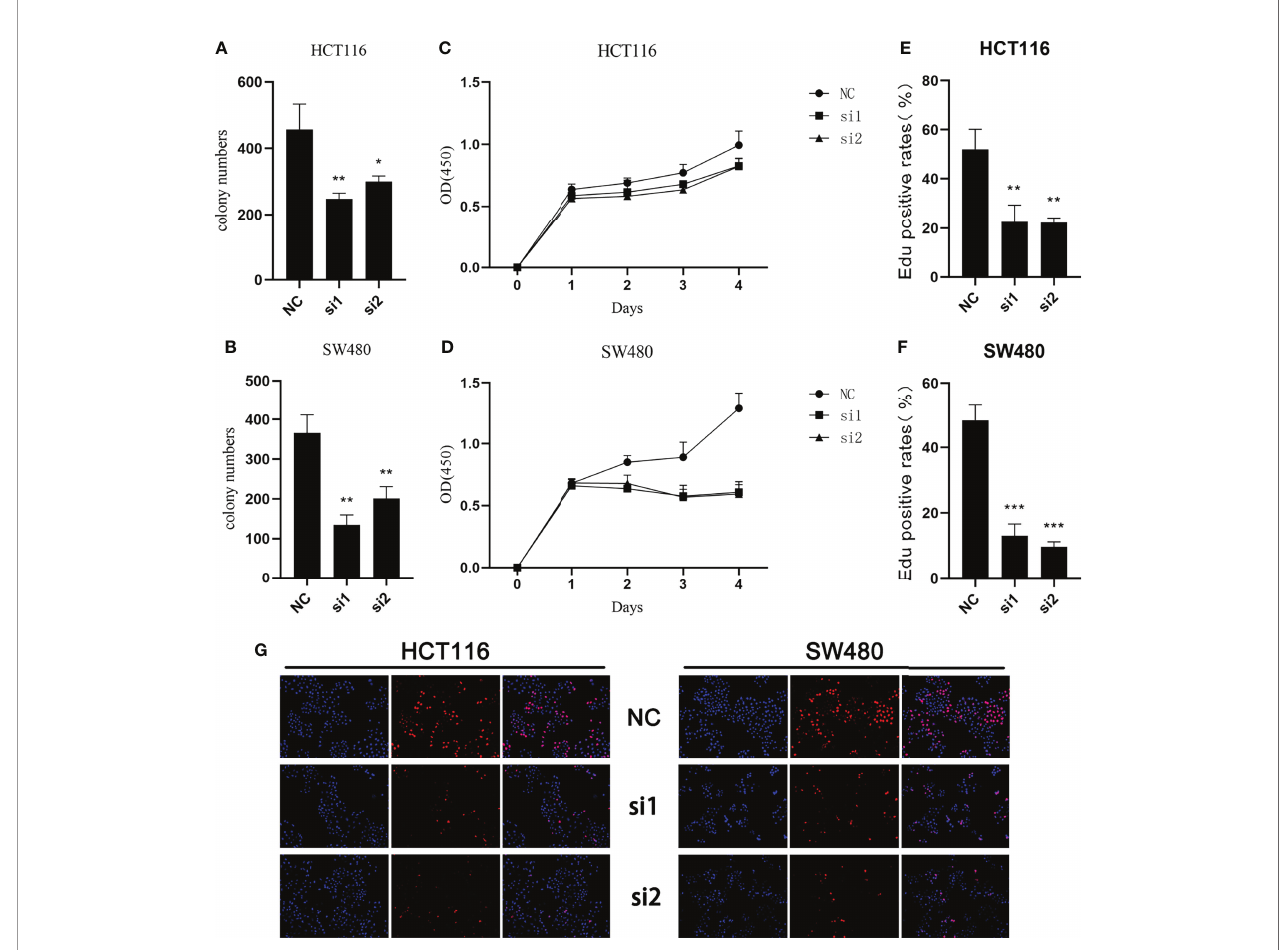
FIGURE 6 | Effects of SCG2 on CRC cells proliferation. (A, B) SCG2 knockdown signi fi cantly reduced colony numbers of HCT116 (A) and SW480 (B) cell lines. (C, D) Reduced proliferative capacity of SCG2 knockdown HCT116 (C) and SW480 (D) cell lines in CCK8 array. (E-G) EdU assay (G , left: DAPI, middle: EdU, right: Merge ) to detect the proliferative ability of CRC cells in the control group and SCG2 downregulation group. SCG2 knockdown signi fi cantly reduced the proliferative ability of HCT116 (E) and SW480 (F) cell lines. * P < 0.05; ** P < 0.01; *** P <